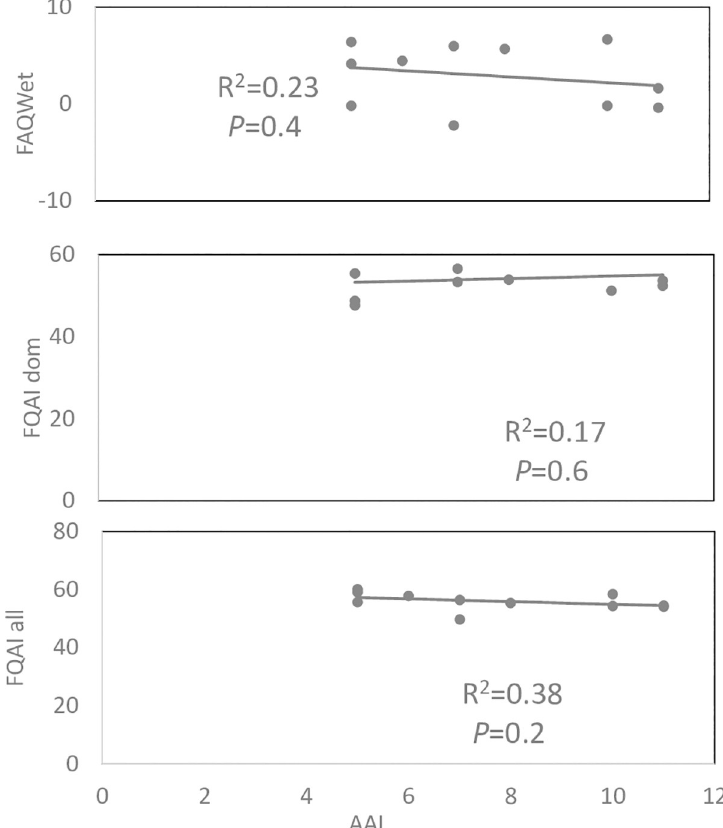
Fig 6. Comparison of linear regression analyses for FQAIall, FQAIdom, and FAQWet with AAI, for summer season for the 11 surveyed wetland sites.